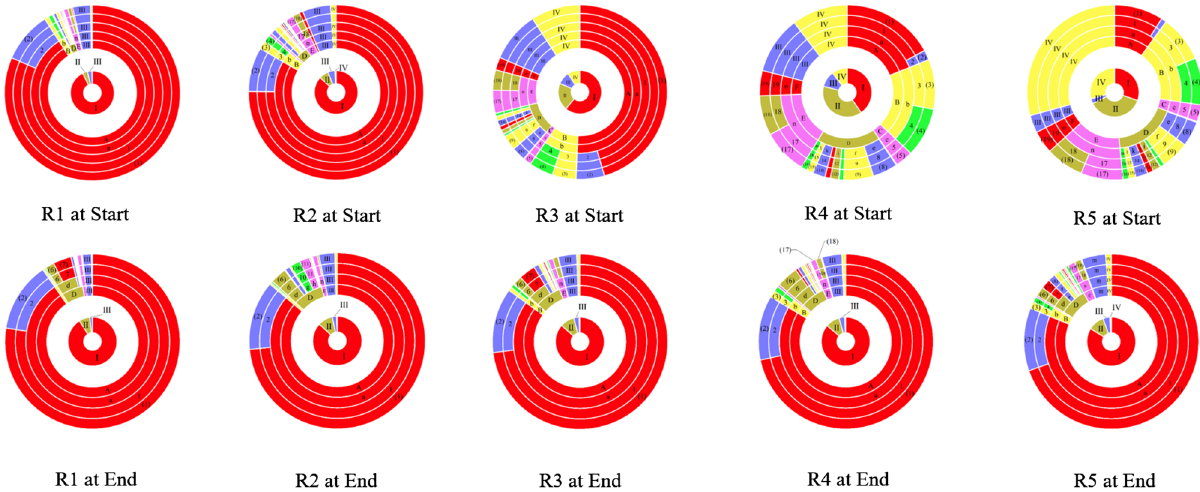
Figure 4. Algal–bacterial Consortia multistage species composition at the Start and End. Consortia with algae/sludge 10:1, 5:1, 1:1, 1:5 and 1:10 (donated as R1 to R5). Start (the operation start-up, the 0 h) and End (the operation end, the 48th h). Autotroph, heterotroph, other of algae, other of bacteria (donated as I To IV). Chlorophyta, Chlorophyta, Cyanophyta, Chloroflexi, Proteobacteria, Bacteroidetes, Bacteroidetes and Nitrospirae in Phylum (donated as A to F). Chlorophyceae, Chlorophyceae, Cyanophyceae, Unclassified_p_ Chloroflexi, proteobacteria, Betaproteobacteria, proteobacteria, Gammaproteobacteria, Alphaproteobacteria, Deltaproteobacteria, Unclassified_p_Bacteroidetes, Unclassified_p_Bacteroidetes, Nitrospirales in Class (donated as a to o). Chlorococcales, Nostocales, Unclassified_p_Chloroflexi, Pseudomonadales, Burkholderiales, Unclassified_c_ Betaproteobacteria, Pseudomonadales, Burkholderiales, Unclassified_c_Gammaproteobacteria, Rhodobacterales, Myxococcales, Unclassified_c_Alphaproteobacteria, Thauera, Unclassified_p_Bacteroidetes, Nitrospirales in Order (donated as 1 to 15). Chlorella, Scenedesmus, Anabaena, Spirulina, Unclassified_p_Chloroflexi, Acinetobacter, Unclassified_o_Pseudomonadales, Burkholderiales, Unclassified_c_Betaproteobacteria, Pseudomonas, Comamonas, Unclassified_c_Gammaproteobacteria, Unclassified_o_Rhodobacterales, Unclassified_o_ Myxococcales, Unclassified_c_Alphaproteobacteria, Thauera, Unclassified_p_Proteobacteria, Unclassified_p_ Bacteroidetes, Nitrospira donated as (1) to (19).